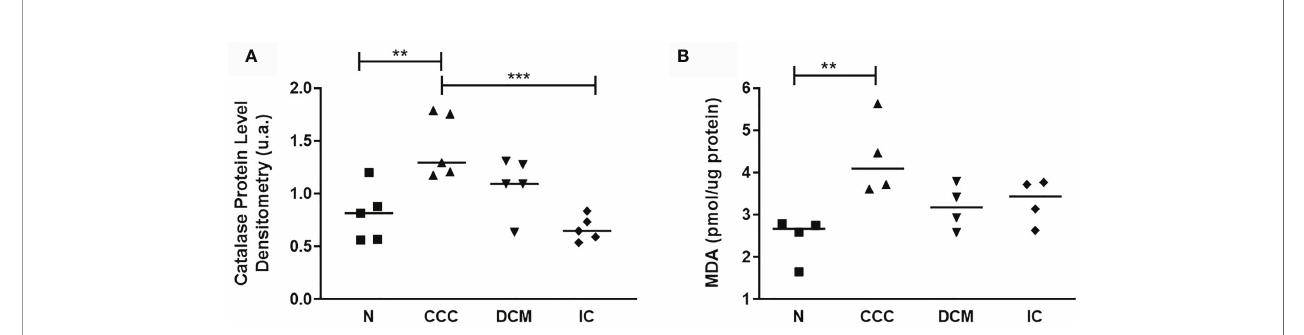
FIGURE 5 | Analysis of antioxidant enzyme Catalase and lipid peroxidation status. (A) Catalase protein levels measured by immunoblotting; the densitometric values were normalized by the total protein for each sample (One-Way ANOVA p = 0.0008). (B) Malondialdehyde (MDA) production, measured by the thiobarbituric acid reactive substances (TBARS) assay (One-Way ANOVA p = 0.0113). The horizontal lines show statistically signi fi cant changes between groups by the Tukey-Kramer test: **p < 0.01; ***p < 0.001.